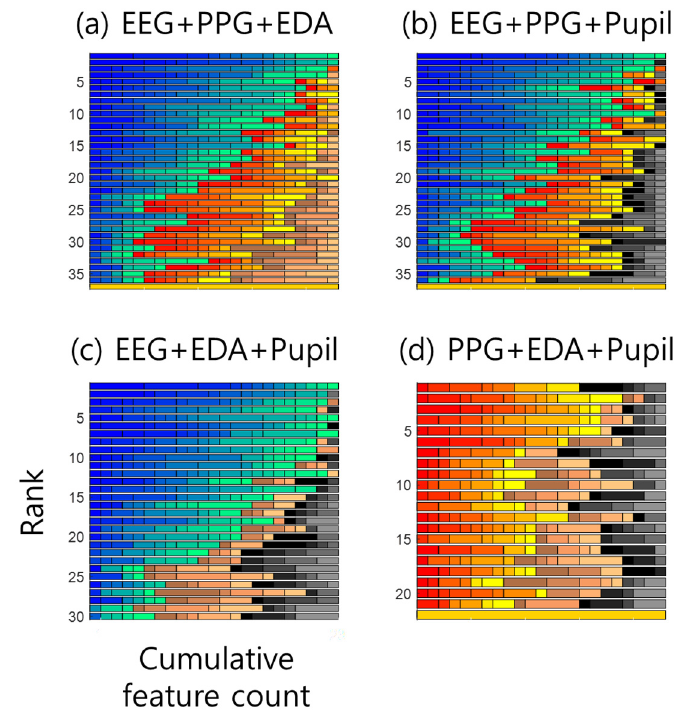
Figure A2. The cumulative feature count results from all possible combinations of three biosignals out of four.